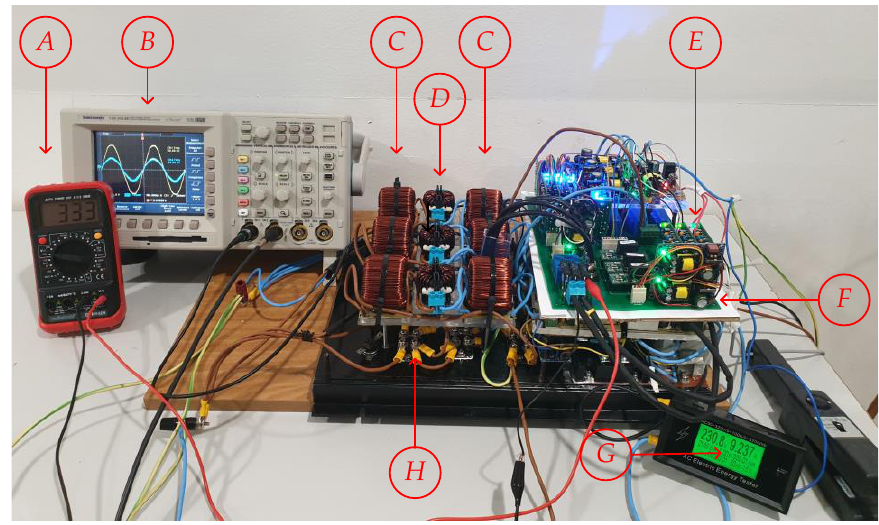
Figure 8. Prototype in development.